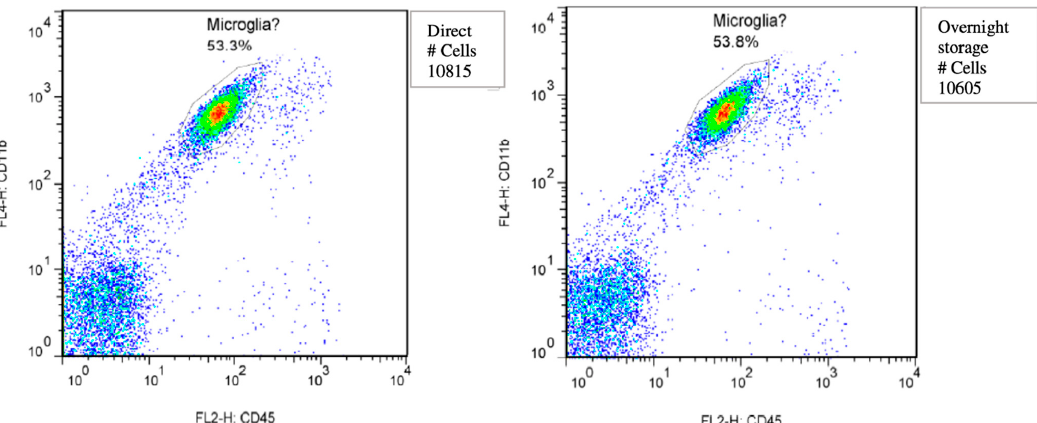
Figure A1. Test samples for flowcytometric analysis of mouse brain directly after termination and after overnight storage in Hybernate-A medium. Both samples are without cerebral perfusion with sterile phosphate buffered saline (PBS) during termination.